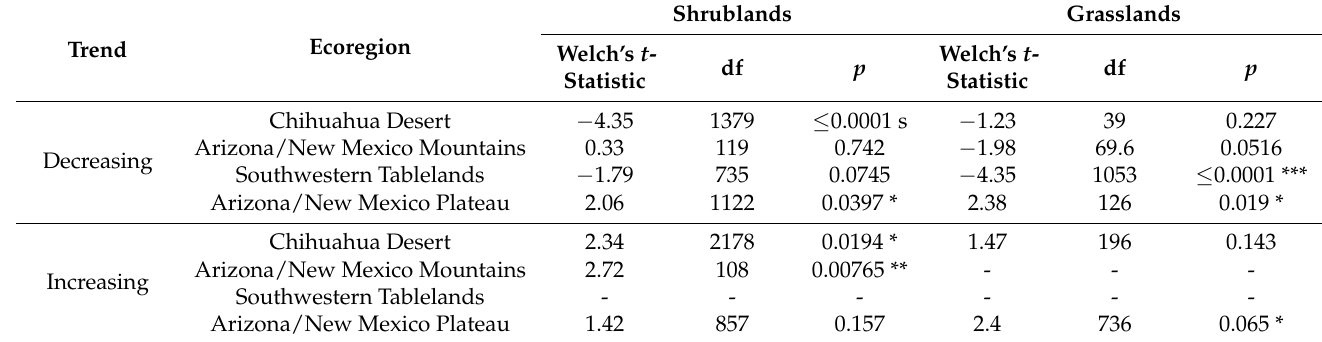
Table A5. Significance of the difference in mean productivity before and after the break years based on the on increasing and decreasing shrublands and grassland randomly selected pixels using RPMS data at the ecoregion